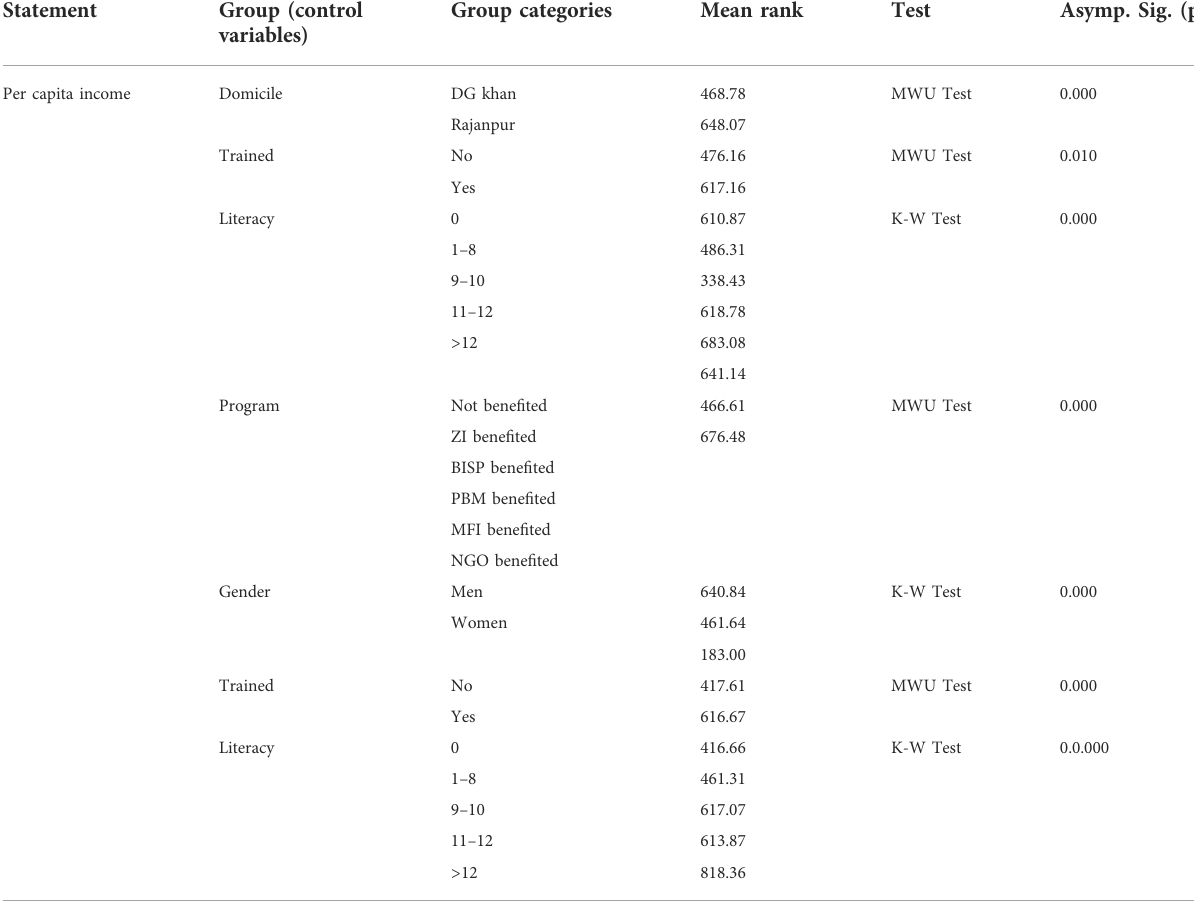
TABLE 6 Signi fi cance of domicile district, literacy, program gender, and training on the per capita income from the previous year.